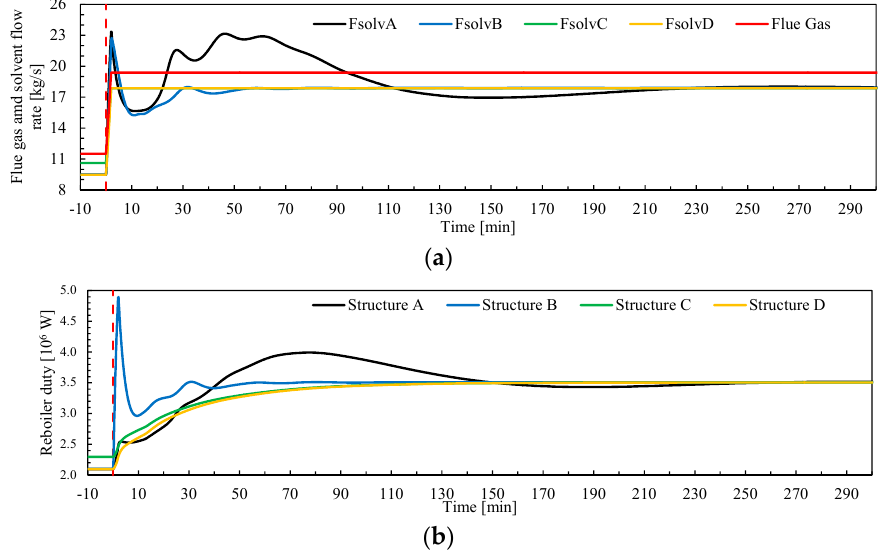
Figure 12. Inputs to the pilot plant during simulations for load change ramp-up (Test 2) from 70 to 100% with a ramp rate of 10%/min increase in flue gas flow rate, for control structures A, B, C and D. ( a ) Flue gas flow rate (kg/s), as a disturbance, and solvent flow rates (kg/s) of the rich pump as manipulated variables (MVs); ( b ) Reboiler duty (W) as MV. The red vertical dotted line shows when the transient event starts at t 0 . Energies 2017 , 10 , 1527